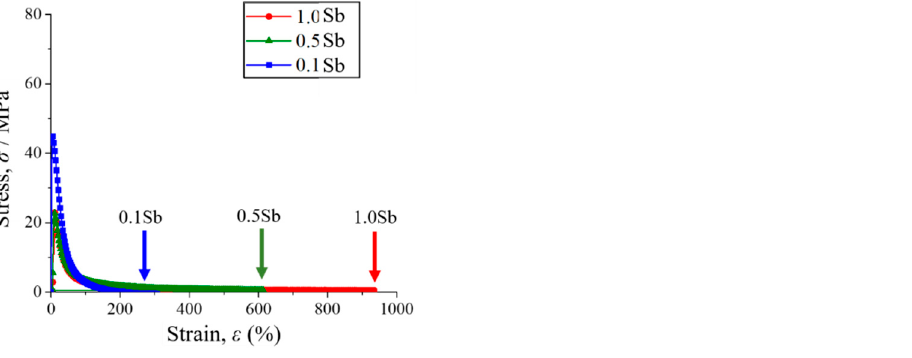
Figure 7. Stress–strain curves of various Sn-40Bi-Sb alloys at 353 K under a strain rate of 5.25 × 10 − 4 s − 1 .